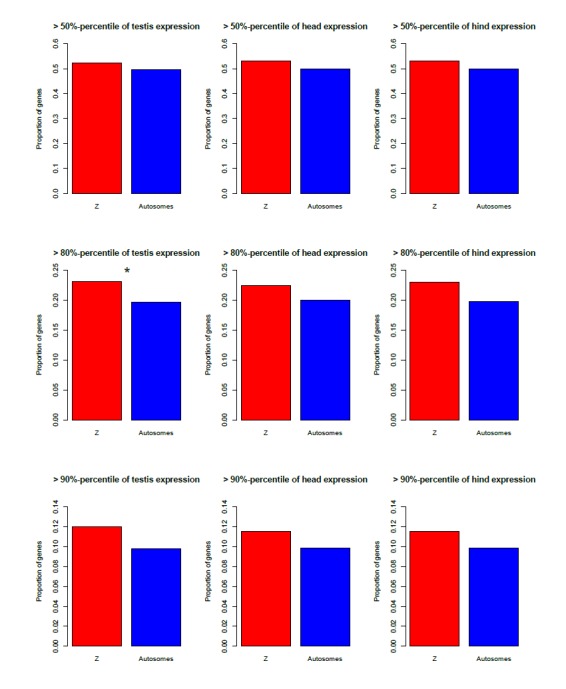
Enrichment of the Z-chromosome for genes highly expressed in three male tissues (testis, head, hind), for three different expression cut-offs.*p<0.05 **p<0.01, Pearsonʹs Chi-squared test with Yatesʹ continuity correction.